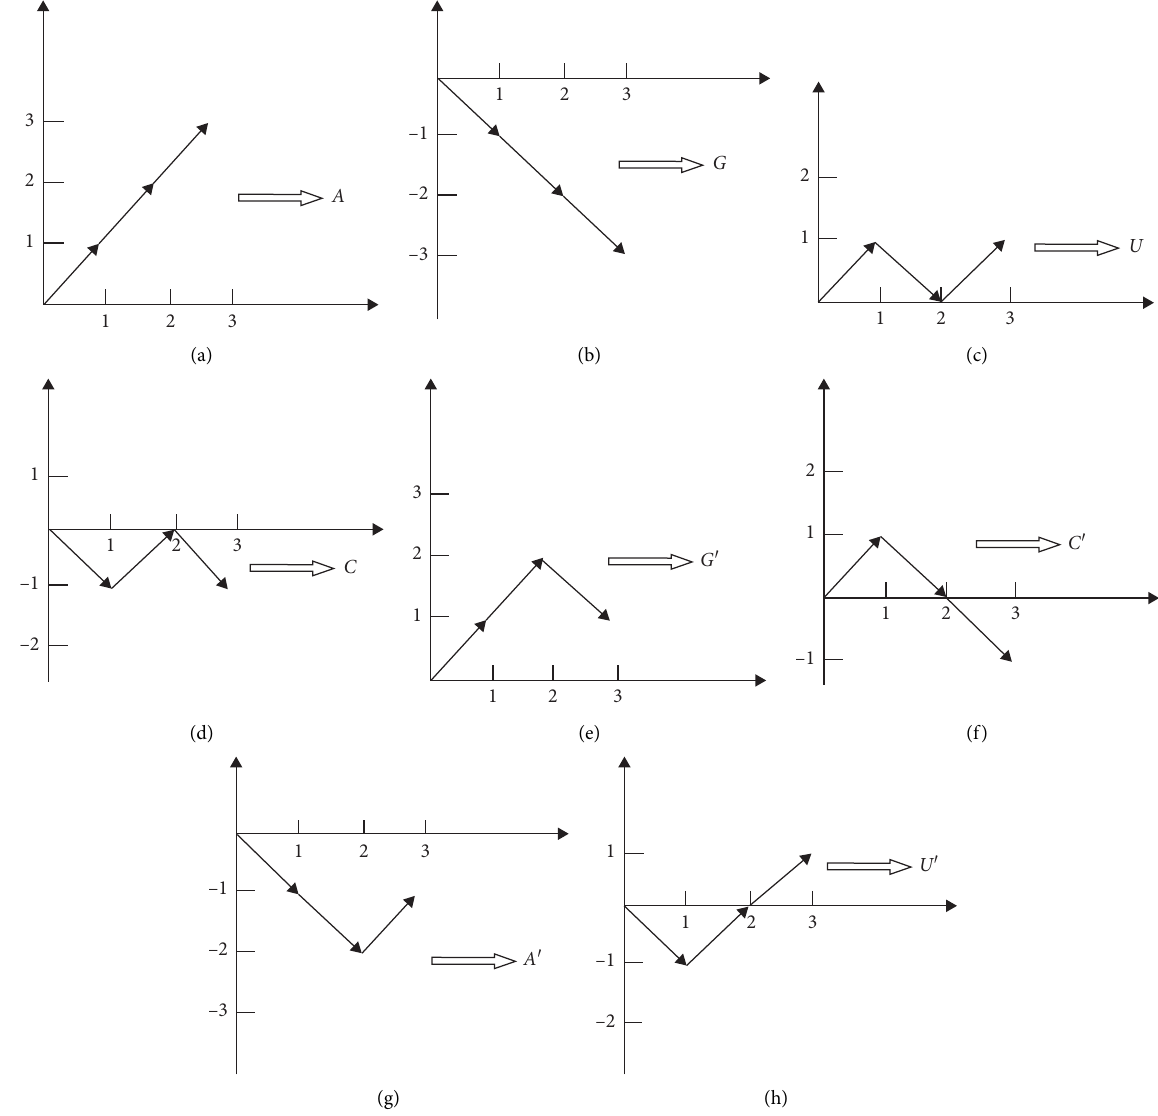
Figure 2: Graphical representation of the eight